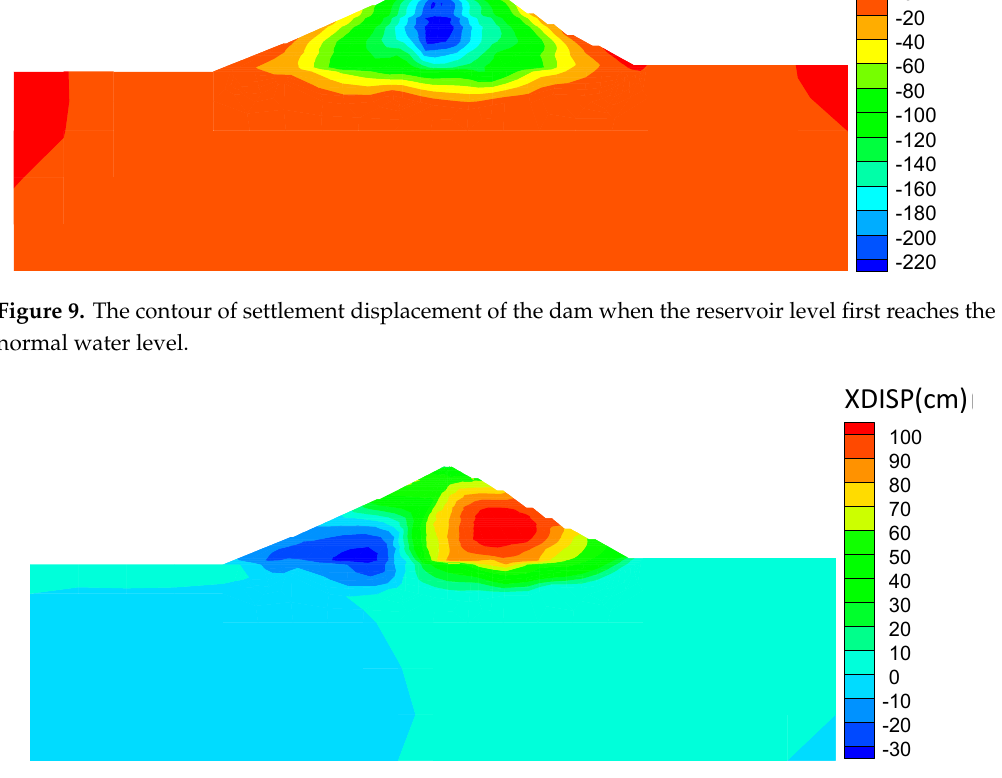
Figure 10. The contour of horizontal displacement of the dam when the reservoir level first reaches the normal water level.